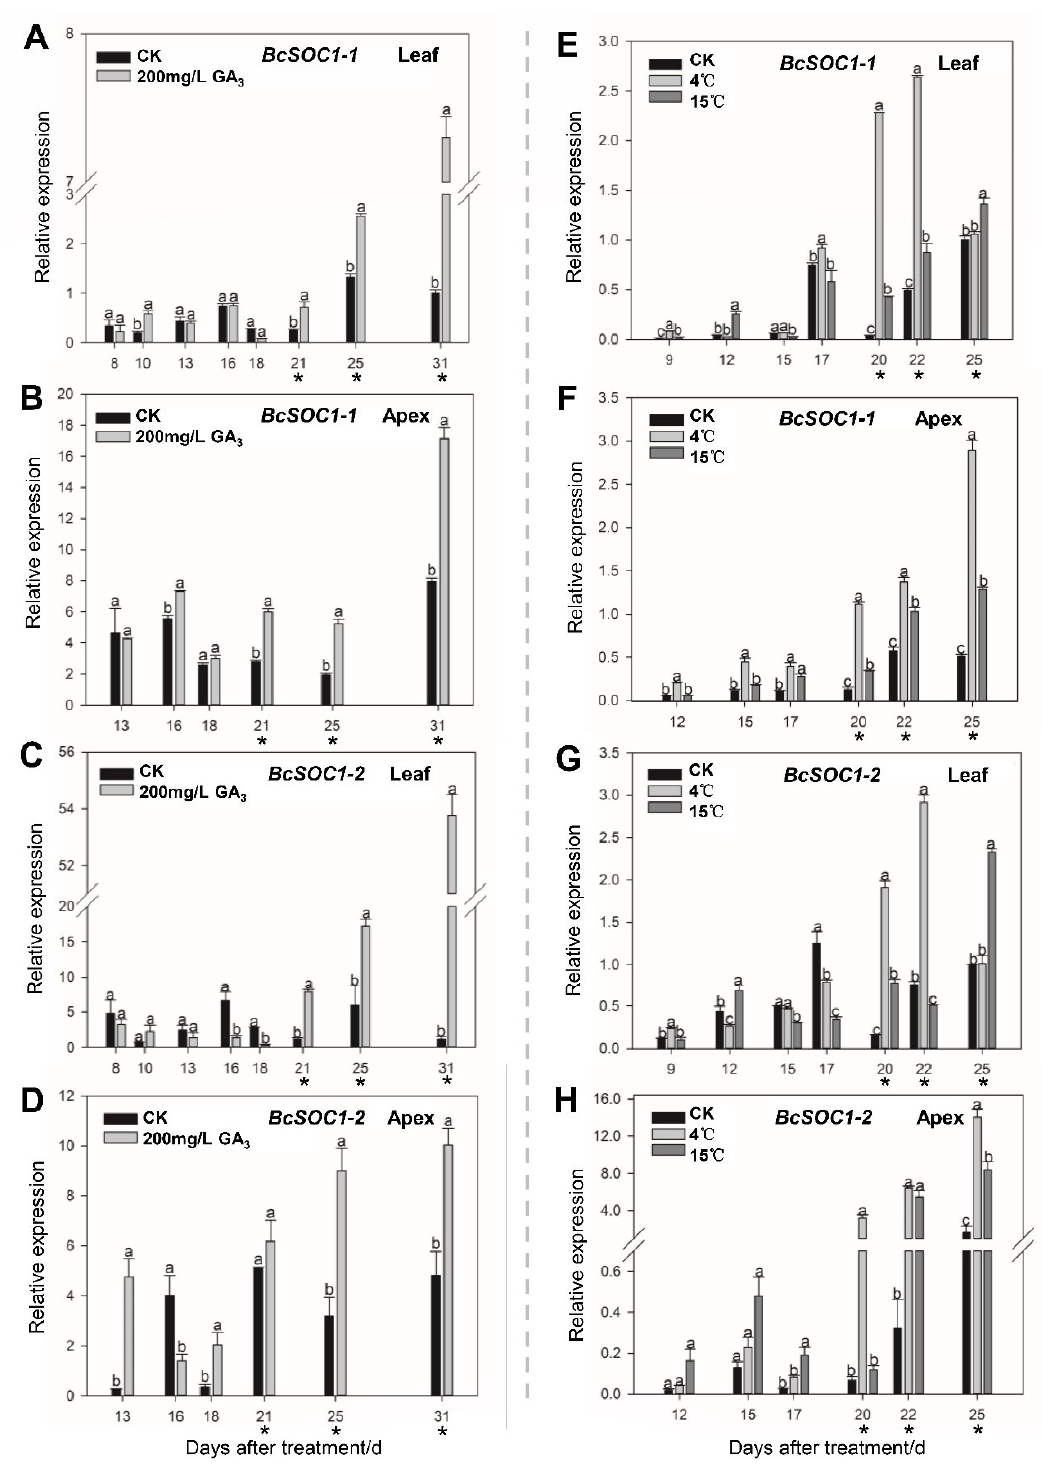
Figure 2. Effects of GA 3 and low-temperature treatments on BcSOC1 expression in flowering Chinese cabbage. ( A – D ) Expression levels of BcSOC1-1 and BcSOC1-2 in the leaves and shoot apex exposed to GA 3 . ( E – H ) Expression levels of BcSOC1-1 and BcSOC1-2 in the leaves and shoot apex exposed to low temperature (4 °C and 15 °C). CK as the control. Error bars represent standard errors. Different letters (a, b and c) indicate significant differences ( p < 0.05) determined using ANOVA. * represents the reproductive phase.